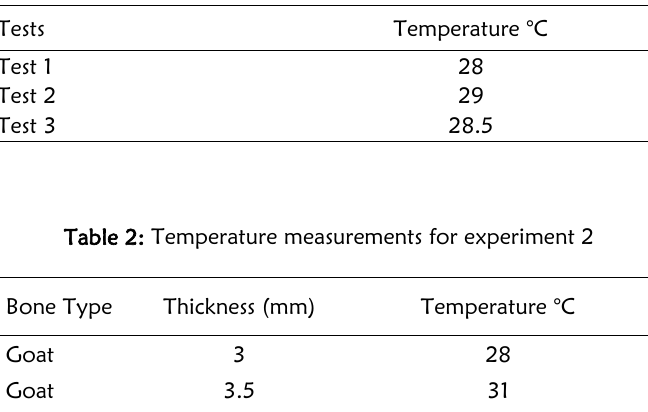
Table 1: Temperature measurements for experiment 1